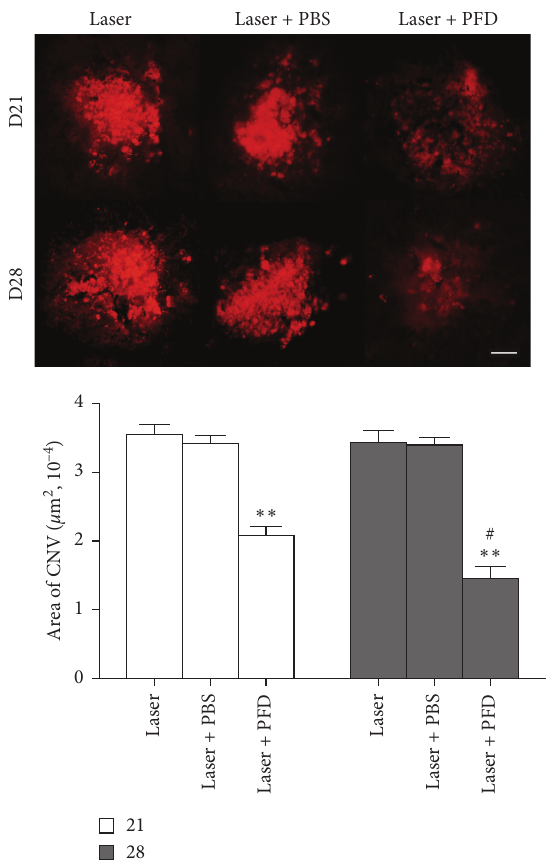
Figure 3: Intravitreal injection of PFD downregulates the ex- pression of TGF- β 2: Smad2/3: p-Smad2/3 and α -SMA. (A: C: F: I) Western blot showed the expression of TGF- β 2: Smad2/3: p-Smad 2/3 and α -SMA in the retinal pigment epithelium-choroid-sclera complex after intravitreal injection of PFD or PBS. (B: D: E: G: H: J) Quantification graphs for TGF- β 2: Smad 2/3: p-Smad 2/3 and α -SMA. Data of the relative protein level normalized to that of GAPDH are presented as the mean ± SD. ∗ P < 0 . 05: ∗∗ P < 0 . 01 vs. day 7. # P < 0 . 05: ## P < 0 . 01 vs. the Laser +PBS group.